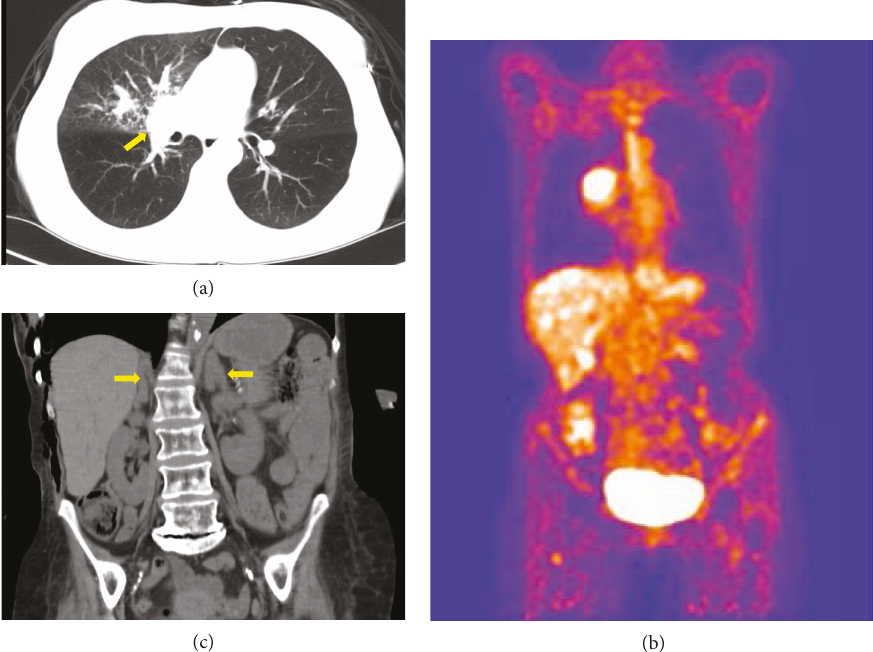
Figure 1: (a) Chest CT (lung window) with a yellow arrow pointing to the right hilar lung primary. (b) PET-CT scan showing an FDG-avid primary tumor in the right lung and metastasis in the liver. (c) Abdomen CT showing bilateral adrenal hypertrophy (yellow